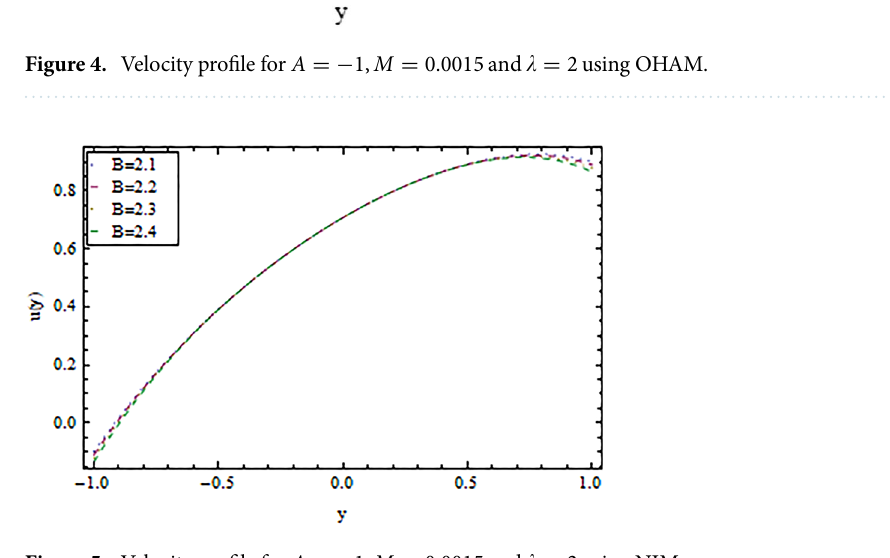
Figure 5. Velocity profile for A = − 1, M = 0.0015 and (cid:31) = 2 using